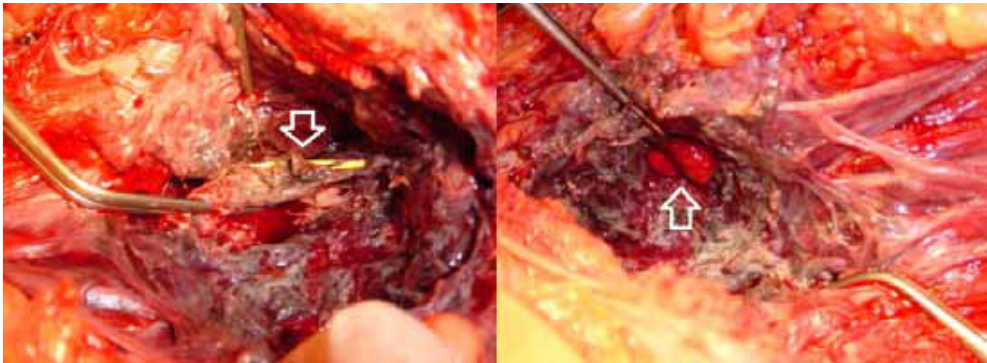
Figure 2 - Intra-operatory image showing extensive destruction or the arterial wall of the left external iliac artery, containing the 7FR Fogarty© catheter (arrow down) and visualization of the sigmoid mucosa (arrow up)